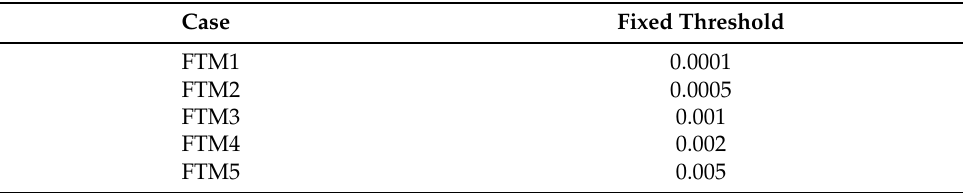
Table 2. Setting for fixed threshold of